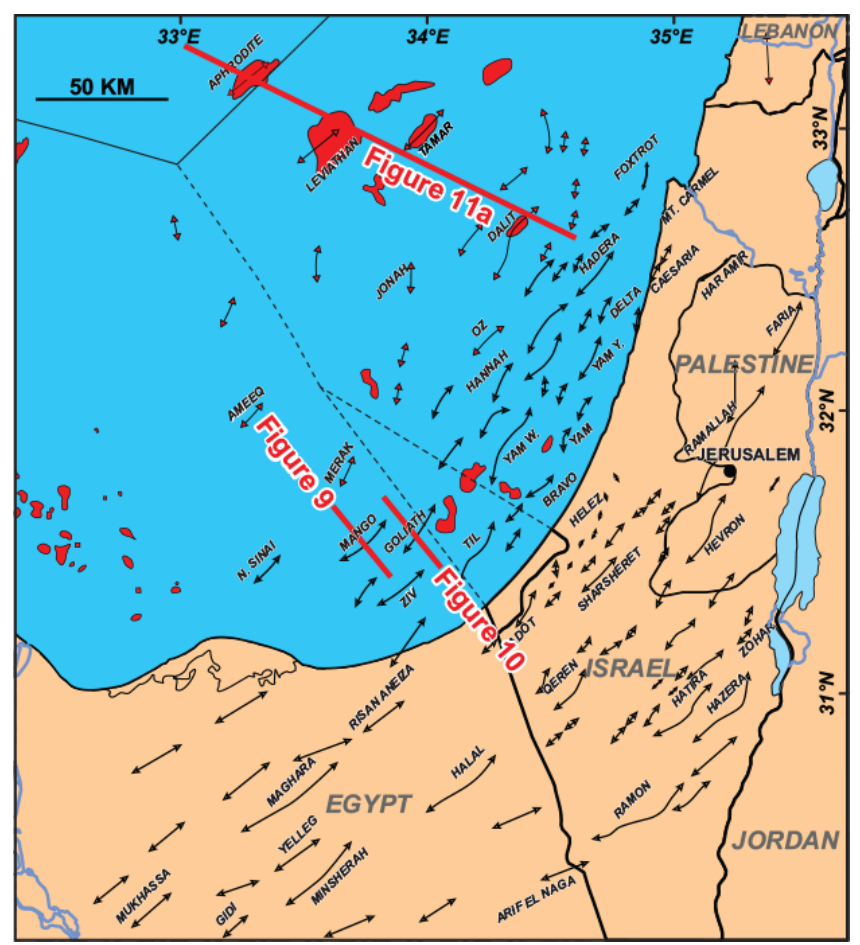
Figure 8. Inventory of the Syrian Arc anticlines, in the border region between Egypt and Israel, modified from Gardosh and Tannenbaum (2014) with some additions in the Egyptian offshore area. The anticlinal axes in black correspond to the early Syrian Arc deformation (Late Cretaceous to Paleogene), whereas the red ones formed during the late Syrian Arc inversion (late Cenozoic). Note the location of the Mango, Goliath and Tamar anticlines in Egypt and Israel (Figs. 9, 10 and